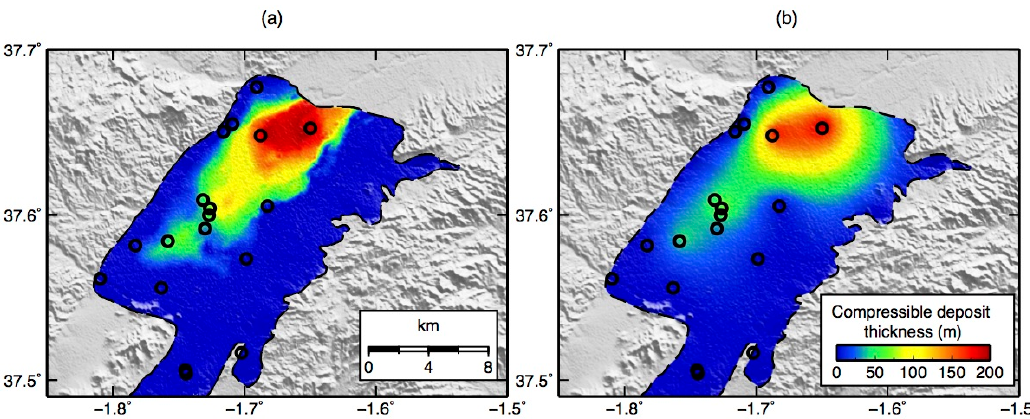
Figure 6. ( a ) Map of compressible soil thickness from this study (Box B in Figure 1a). ( b ) Compressible soil thickness map from [28]. Circles indicate the location of the 18 boreholes where the thickness of the compressible deposit was measured. Map of residuals between maps ( a , b ) is shown in Supplementary Figure S2.